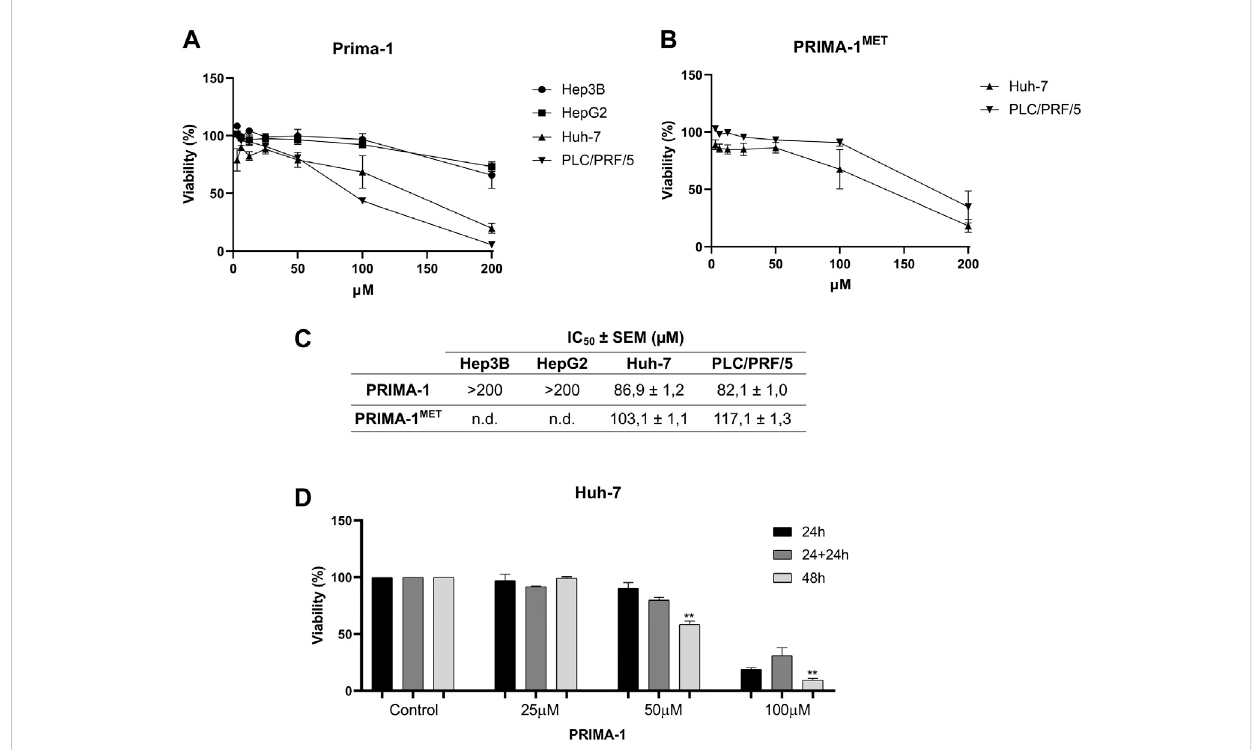
FIGURE 5 PRIMA-1 and PRIMA-1 MET preferentially inhibit HCC mutant p53 cell lines. Cells were treated with different concentrations of PRIMA-1 (A) and PRIMA-1 MET (B) for 24 hand analyzed byMTT. (C) IC 50 valueswereobtained from thedose-response curves. (D) Reversibility assay ofHuh-7cells treated with25,50,and100 µMPRIMA-1for24,24+24,and48 h,respectively.Statisticalanalysisinrelationto24 htreatment** p < 0.005).SEM:standarderror. n.d. not